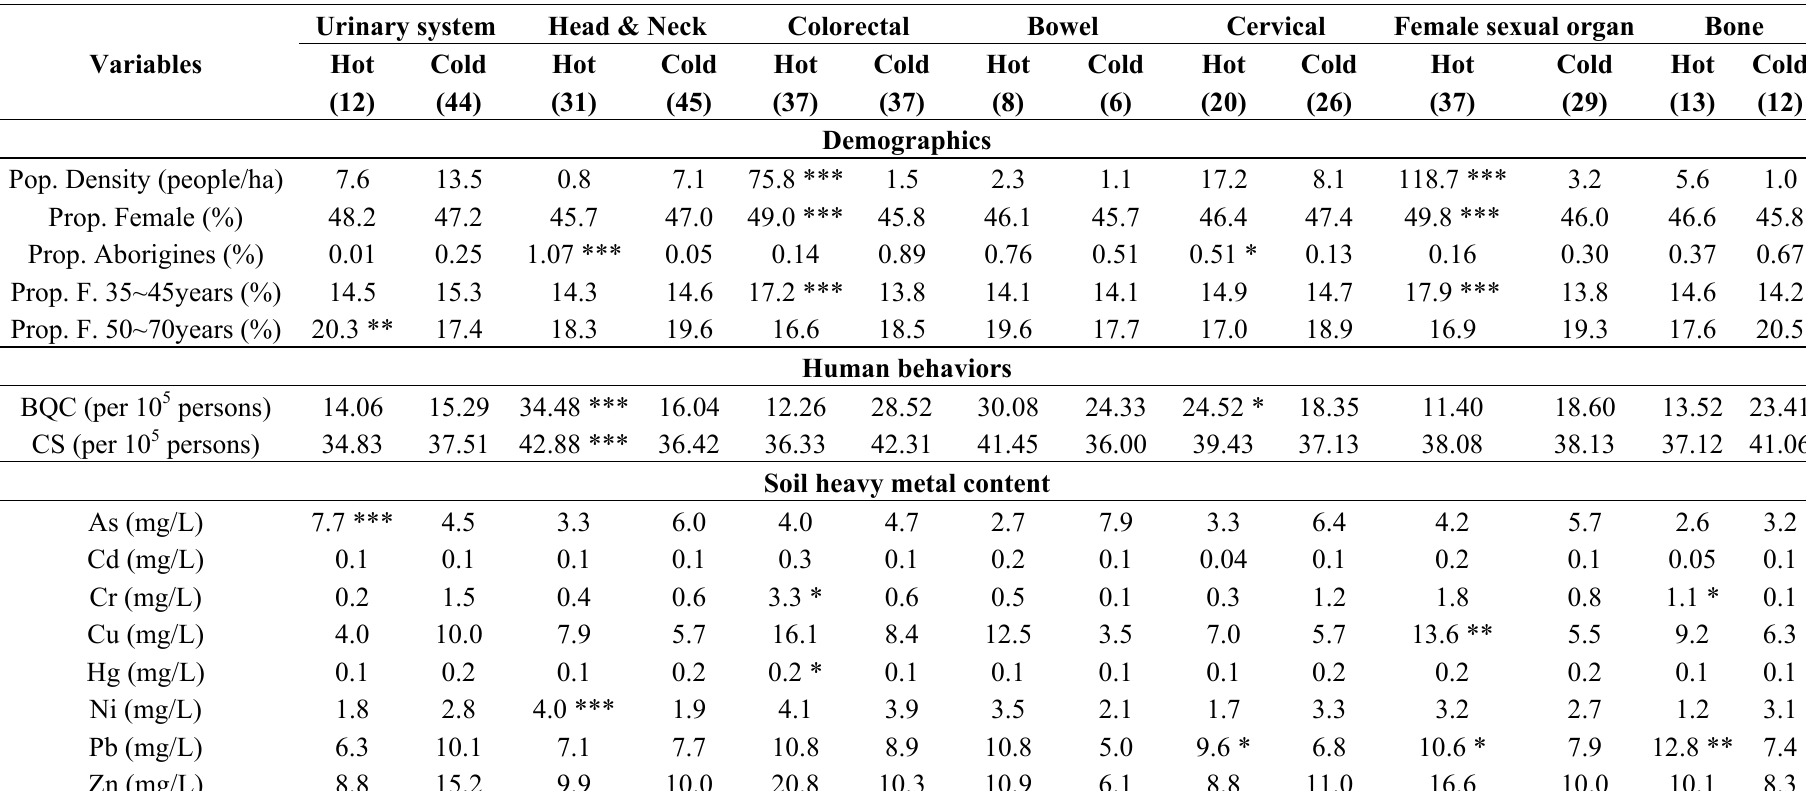
Table 4. Summary of characteristic difference between the geographic hot and cold spots in seven major cancer